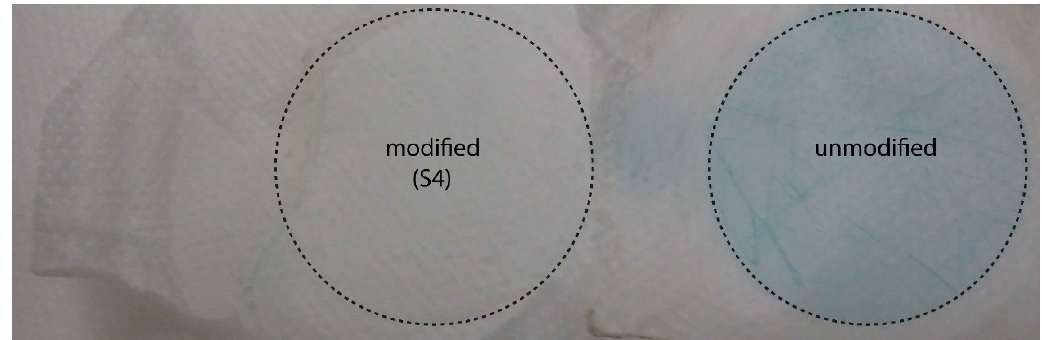
Figure 9. (Left) A picture of the modified (S4) fabric (self-cleaned) and (right) the unmodified fabric (colored blue by MB dye) with a marked area of tested surfaces after photodegradation experiments.